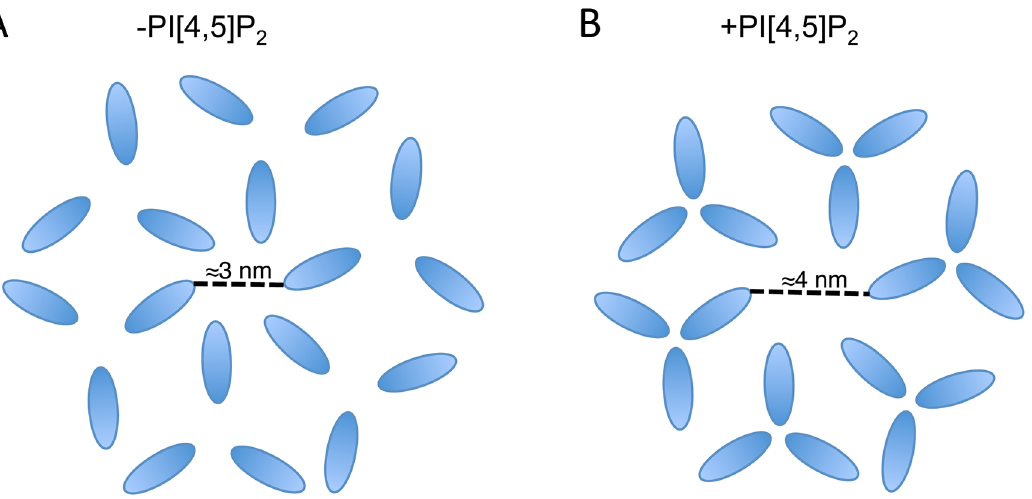
Figure 9. Schematic of two possible MA lattices. MA arrangements are based on the data published in Alfadhli et al. (2007) and Alfadhli et al. (2009) [35,51]; in those papers CA is also shown forming a hexameric lattice beneath MA. (A) In the absence of PI[4,5]P 2 MA forms a hexamer reflecting the underlying CA lattice. (B) In the presence of PI[4,5]P 2 MA forms trimers resulting in a larger space at the center of the hexamer. Based on the location of Env-incorporation defective mutants in MA, the Env CT may be located at the hexameric center. The structure of the Env CT